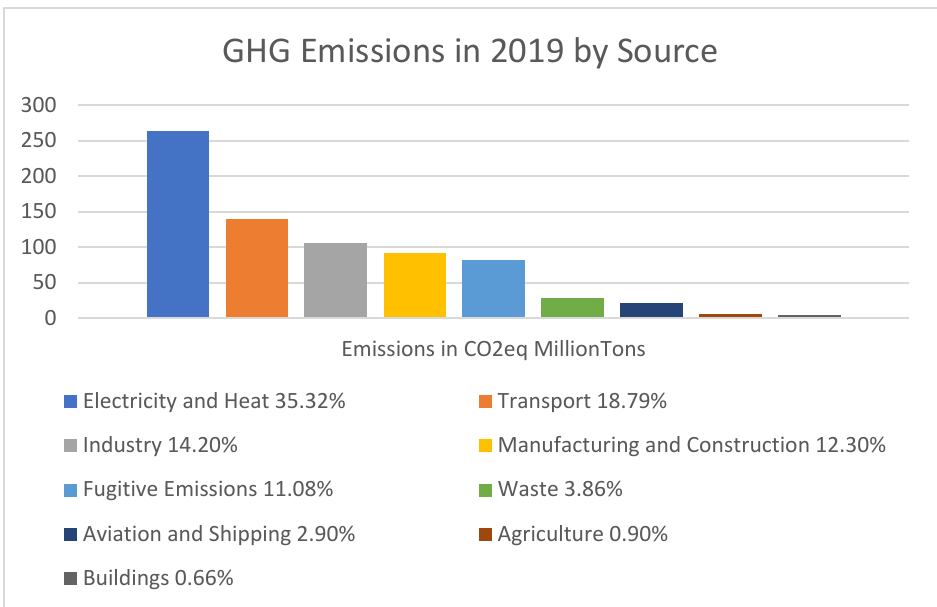
Figure 6. GHG emissions in 2019 by source (data from ref. [35]).